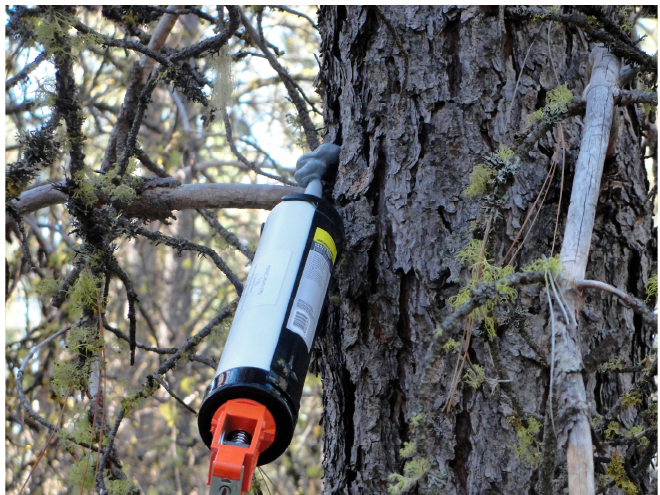
Figure 8. An early prototype of SPLAT ® Verbenone Plus (acetophenone, ( E )-2-hexen-1-ol, ( Z )-2- hexen-1-ol, and verbenone; ISCA Technologies Inc., Riverside, CA, USA) applied to the bole of a ponderosa pine ( Pinus ponderosa ), California. Photo credit: C.J. Fe tt ig, USDA Forest Service.